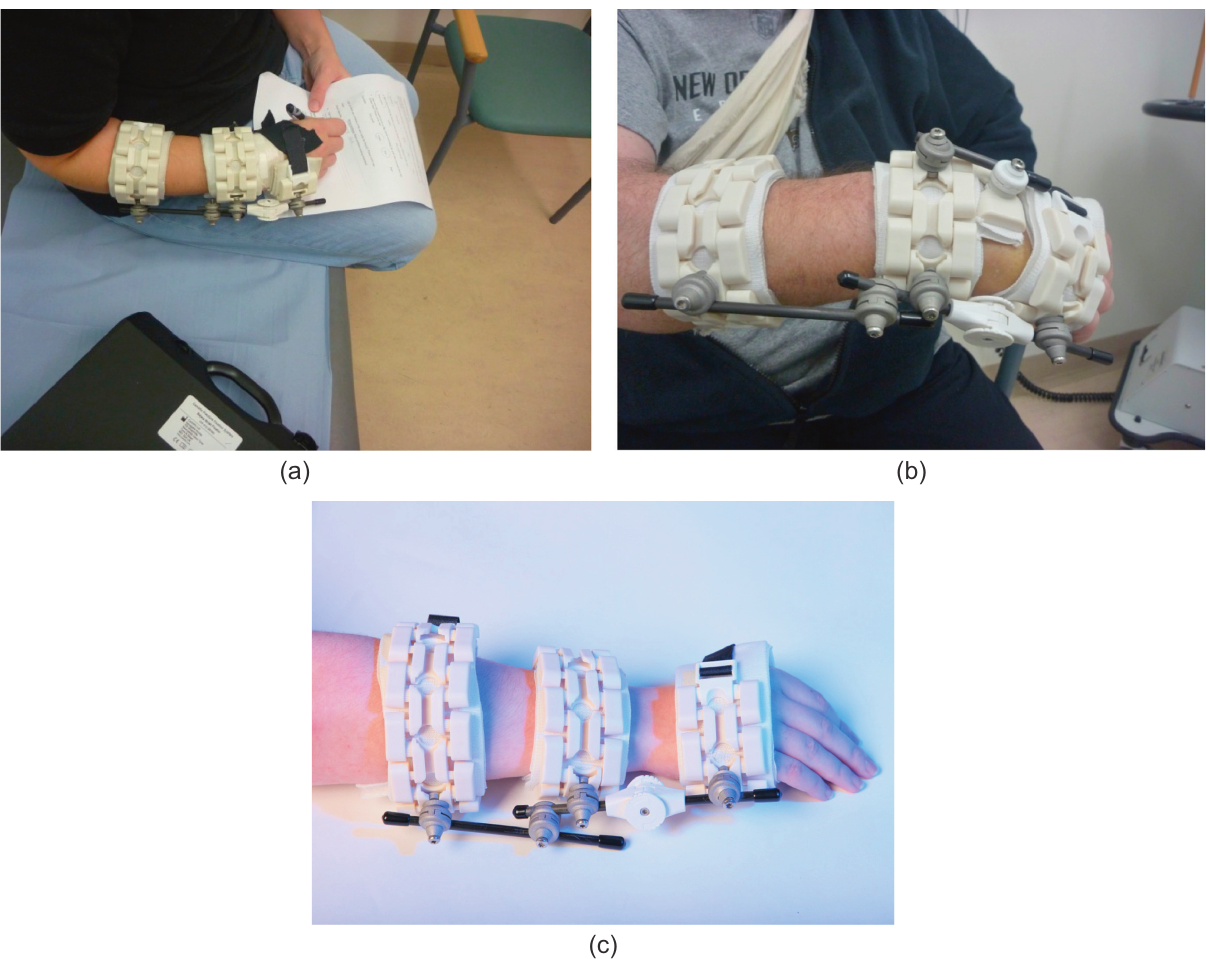
Figure 3. (a) Non-invasive fixator ( Cambfix , Polyarmour ) on the right forearm of a female patient with DRF who can hold a pen, mobilise the wrist and rest the forearm. (b) Non-invasive fixator ( Cambfix , Polyarmour ) on a male patient in standard configuration: three articulated radiolucent bracelets lined with waterproof polylattice membrane, interconnected by carbon fibre rods, which are captured by connectors that allow 360 degree freedom of movement before setting the system rigid. (c) Cambfix device on the wrist showing three articulated bracelets with interconnecting rods and selectively lockable hinge on the ulnar side. (Photograph courtesy of Cambfix